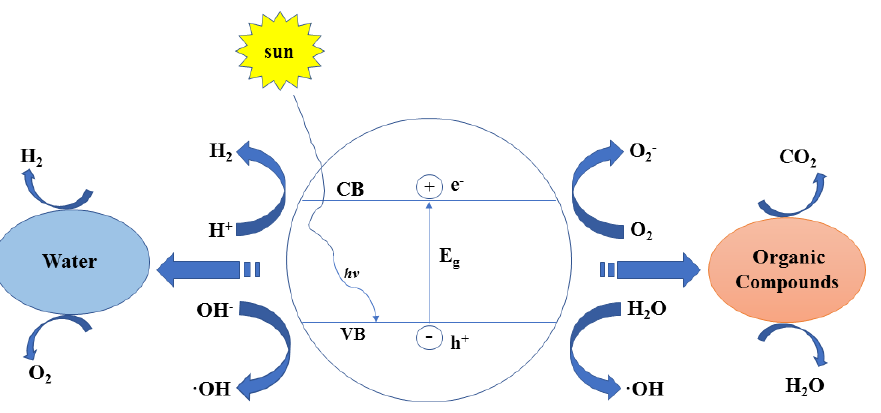
Figure 1. Schematic diagram of the principle of photocatalytic degradation of organic matter.